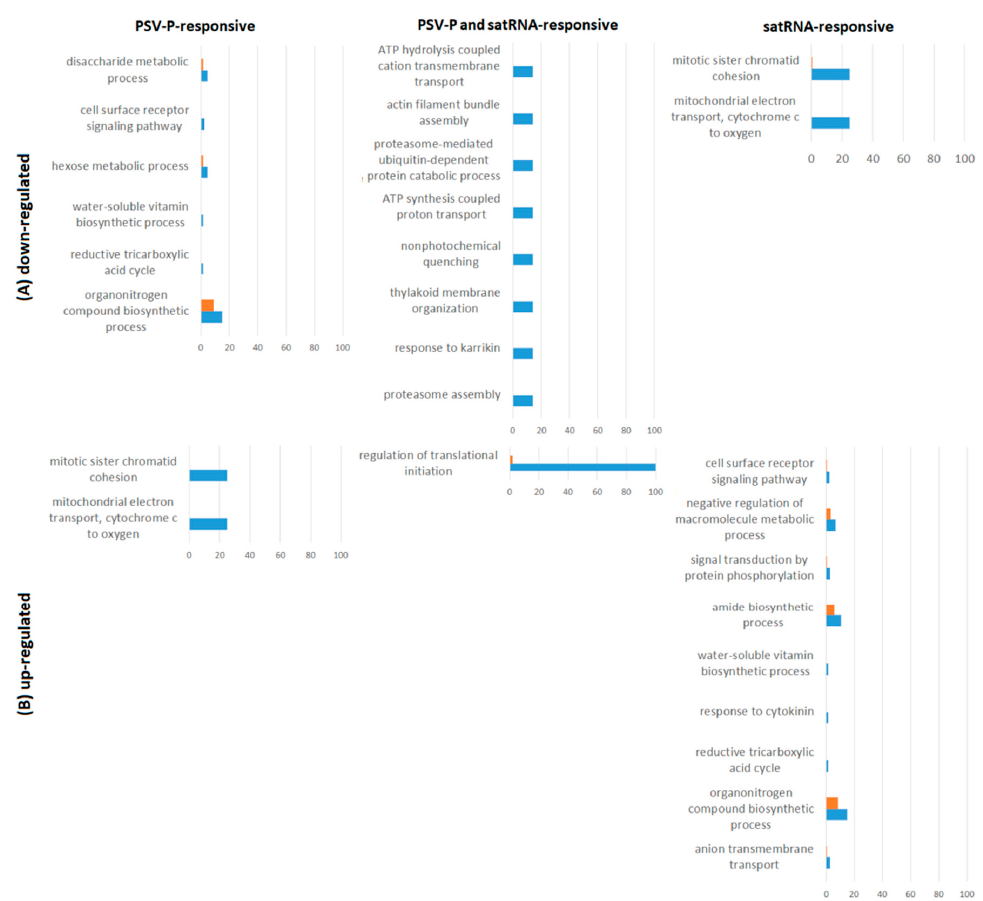
Figure 7. GO enrichment for biological process for phosphoproteins after normalization to protein levels. The distribution of GO terms was analyzed separately for down-regulated ( A ) and up- regulated proteins ( B ) using Blast2GO